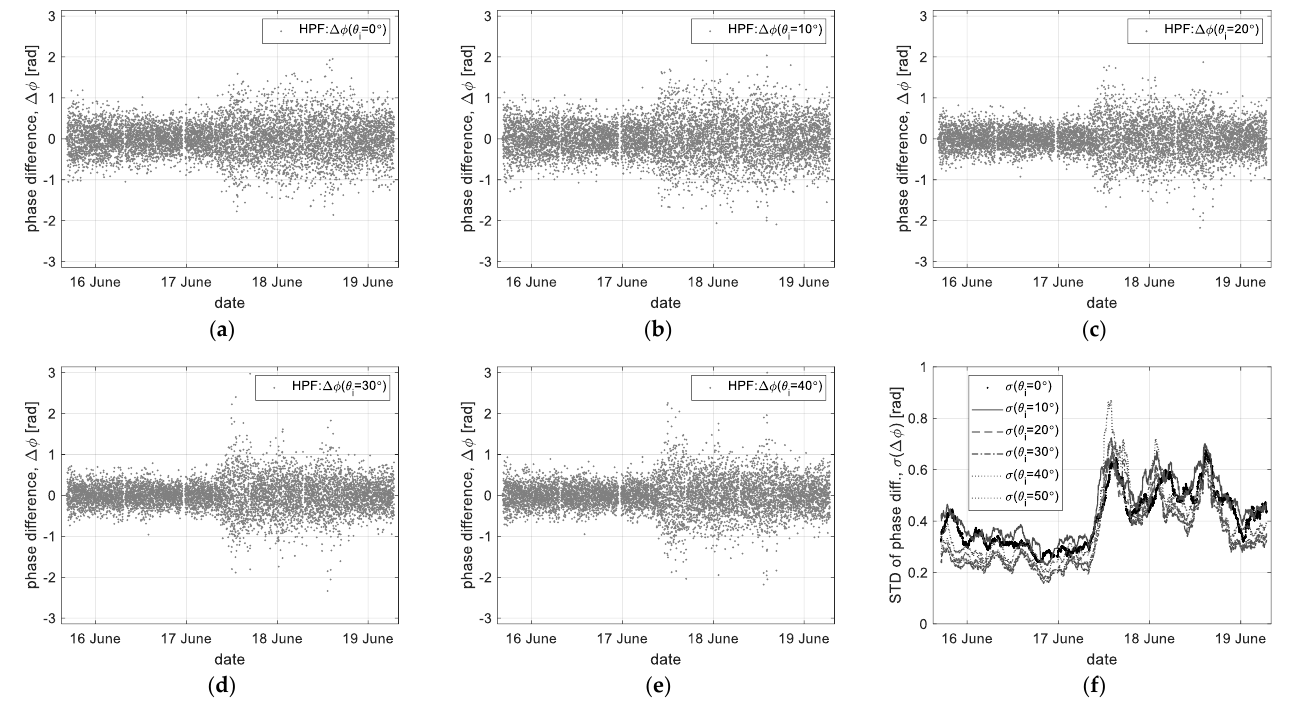
Figure 7. High-pass filtered data (‘HPF’) only of the time-series interferometric phase data ( ΔΦ): ( a – e ) the filtered data at each incident angle, and ( f ) the standard deviation of HPF data ( σ ( ΔΦ )).